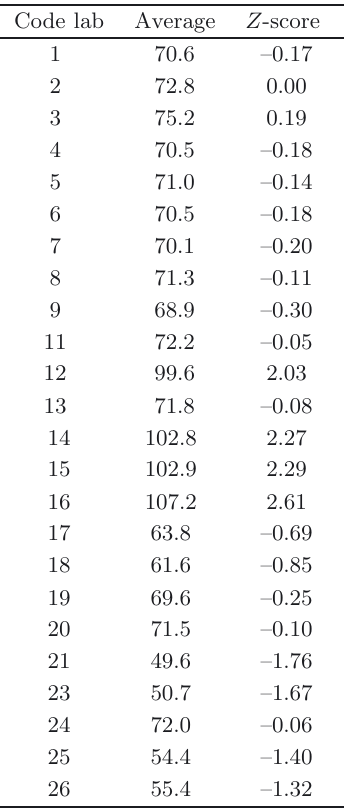
Table 8. Results of the histamine amount by the HPLC method in the levels 1 and 2 PTS